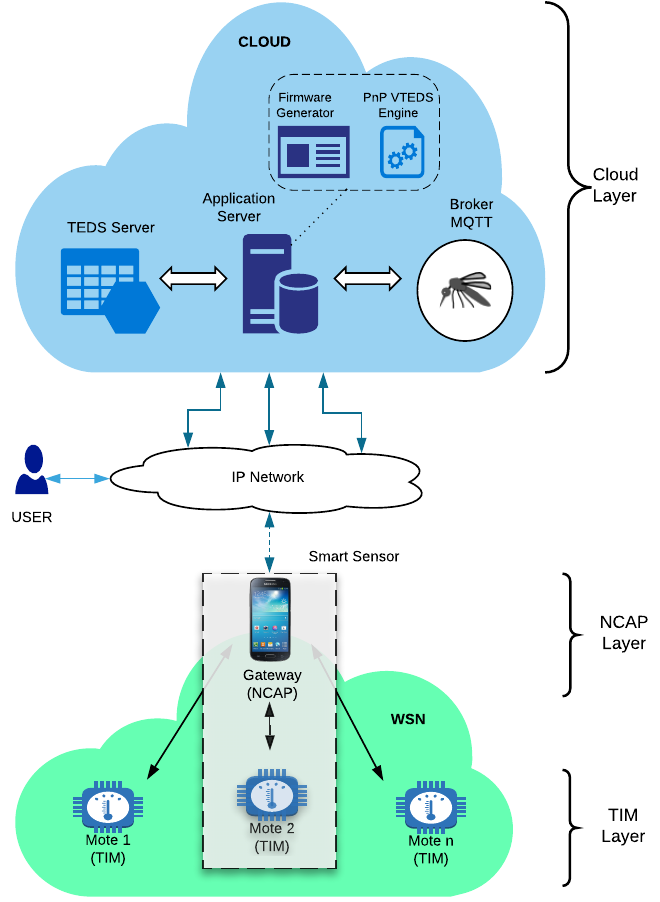
Figure 6. Plug-and-play architecture based on Virtual Transducer Electronic Data Sheet